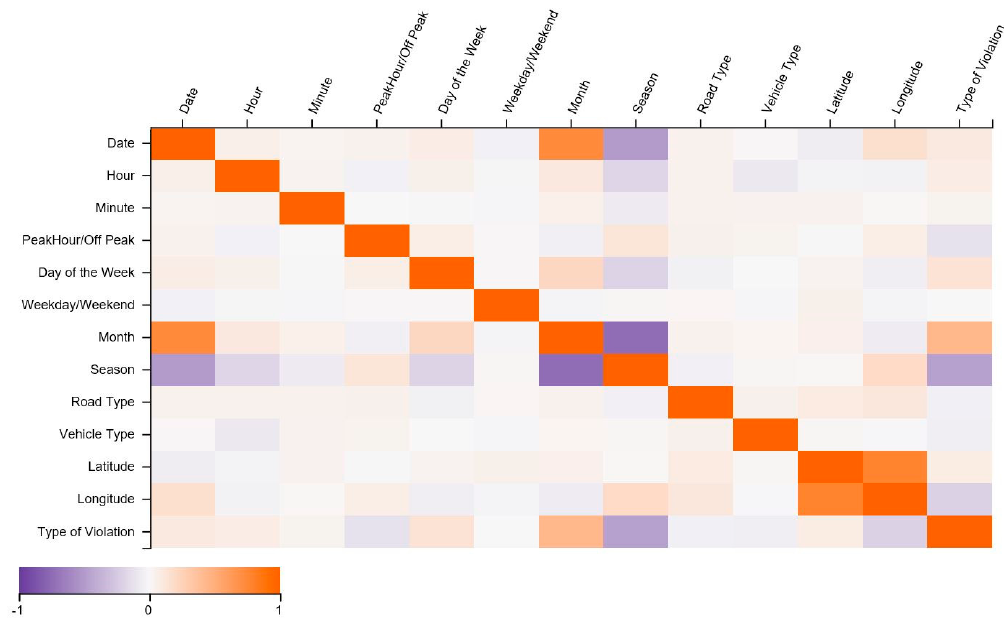
Figure 5. Variables correlation matrix.